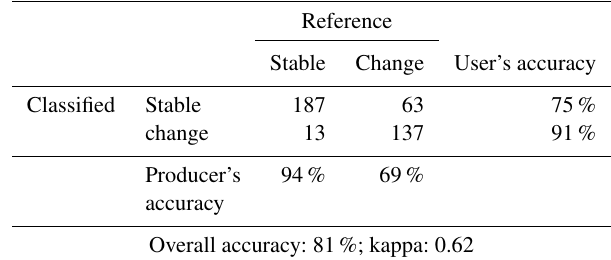
Table 2. Accuracy of change detection using LANID maps. Change is defined as frequency difference between the two sub-periods